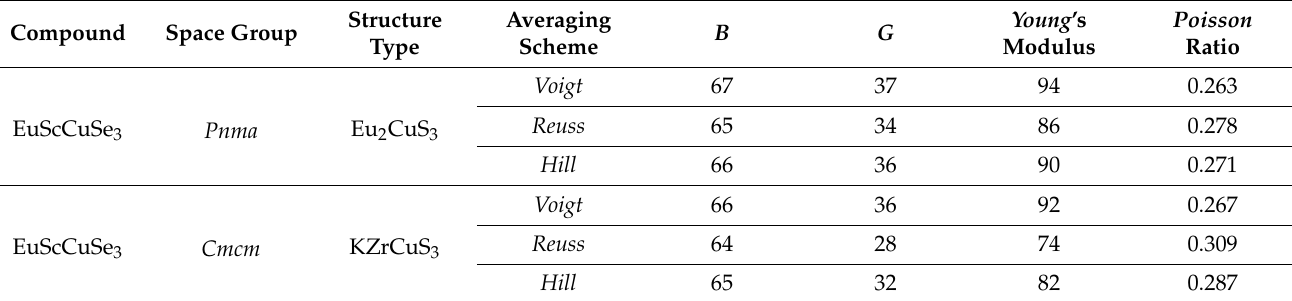
Table 5. Bulk ( B ), shear ( G ), and Young ’s modulus (GPa) of EuScCuSe 3